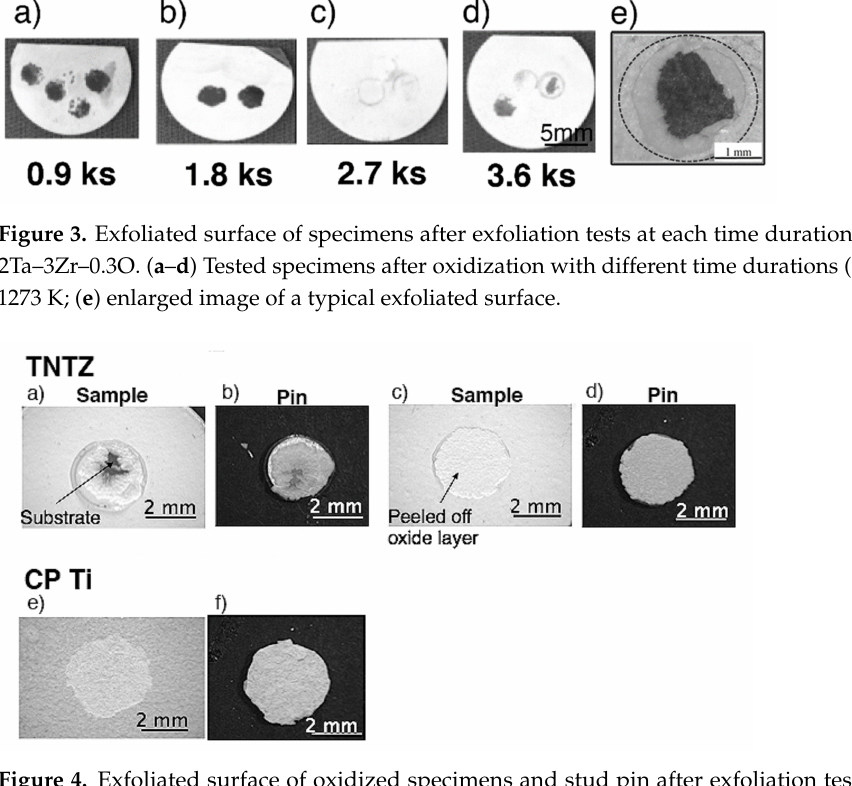
Figure 4. Exfoliated surface of oxidized specimens and stud pin after exfoliation tests. Oxidized condition was at 1273 K for 3.6 ks in air: ( a – d ) Ti–29Nb–13Ta–4.6Zr and ( e , f ) CP Ti. ( a , b ) σ f ≈ 70